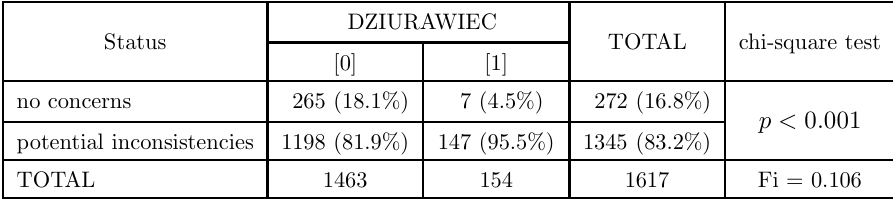
Table 2. Relationship between the occurrence of the “dziurawiec” ingredient and its status